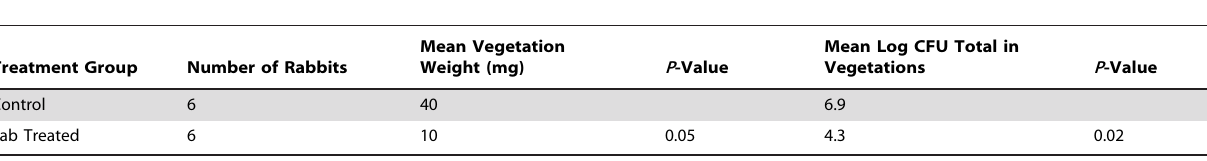
Table 3. IgG Fabs against aggregation substance reduce the severity of enterococcal endocarditis after challenge with AS + E. faecalis